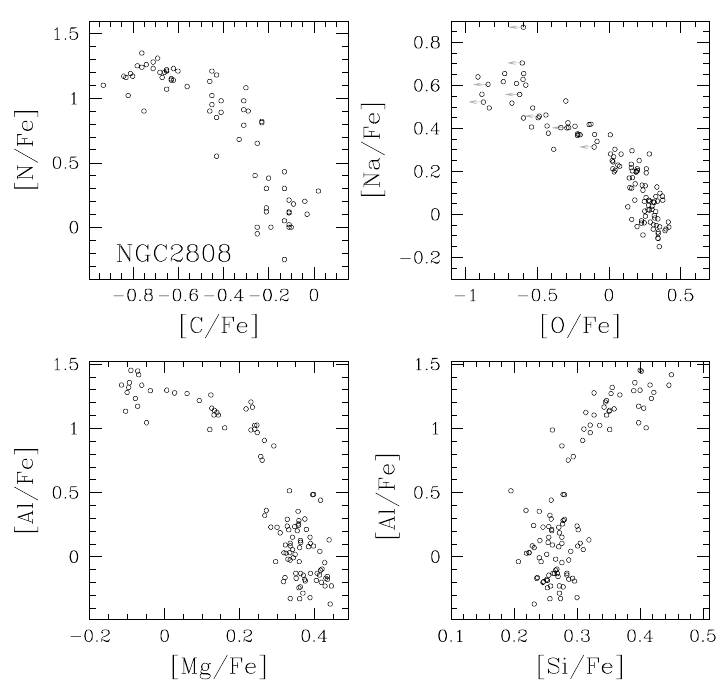
Figure 5. This figure shows the C–N, Na–O, Mg–Al anticorrelations and the Al–Si correlation for NGC2808. C and N abundances are from Carlos et al. [134], whereas the remaining elements are taken from Carretta [119] and Carretta et al.